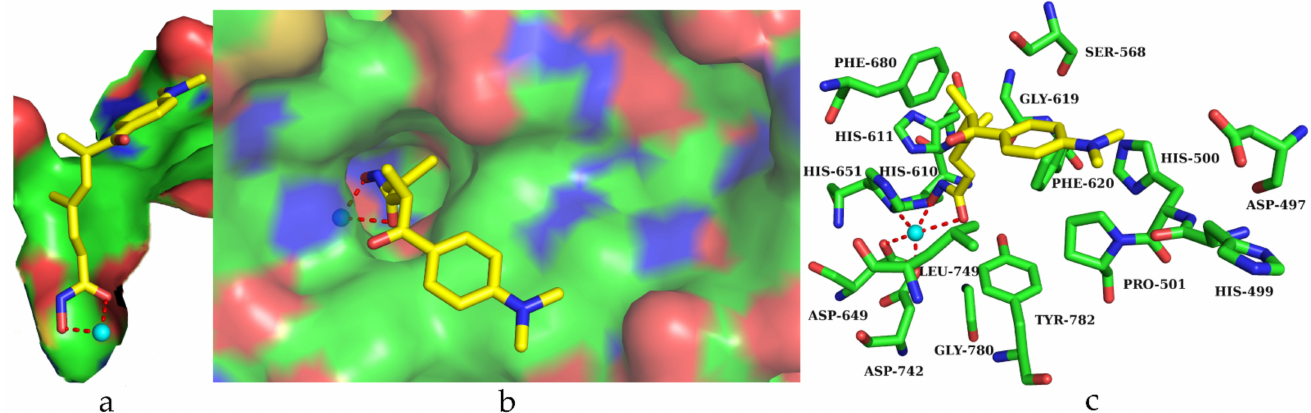
Figure 2. Active site analysis of HDAC6 (PDB ID: 5edu): ( a ) cross-sectional view of the active site (surface represented) with ( R )-TSA (sticks represented); ( b ) surface representation of the cavity with ( R )-TSA (sticks represented); ( c ) important amino acids around ( R )-TSA (sticks represented). Zn 2+ ion is shown as a cyan sphere and metal coordination interactions are indicated as red dashed lines. The color codes of carbon, oxygen, and nitrogen are green, red, and blue, respectively. The carbon atoms of ( R )-TSA are colored in